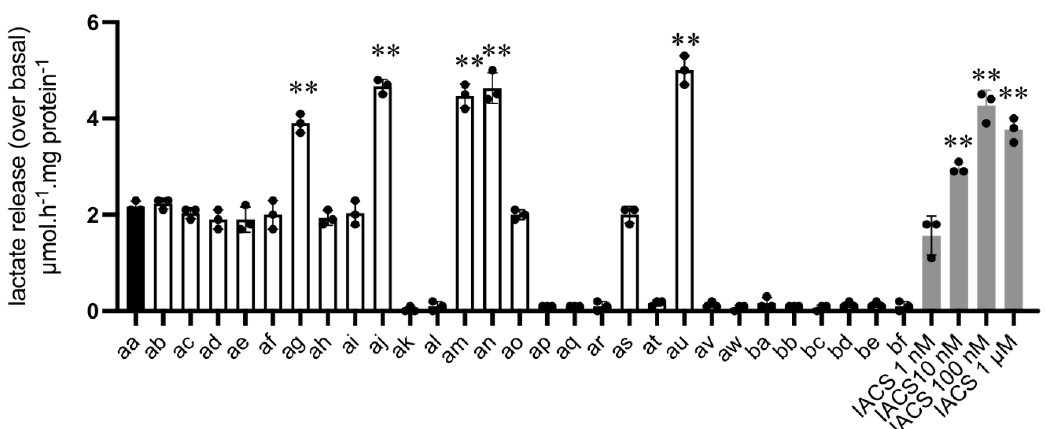
Figure 3 and Table 2 , assay 1). Interestingly, the highly potent complex I inhibitor IACS- 010759 [10] stimulated L-lactate release to a similar extent to that observed in response to